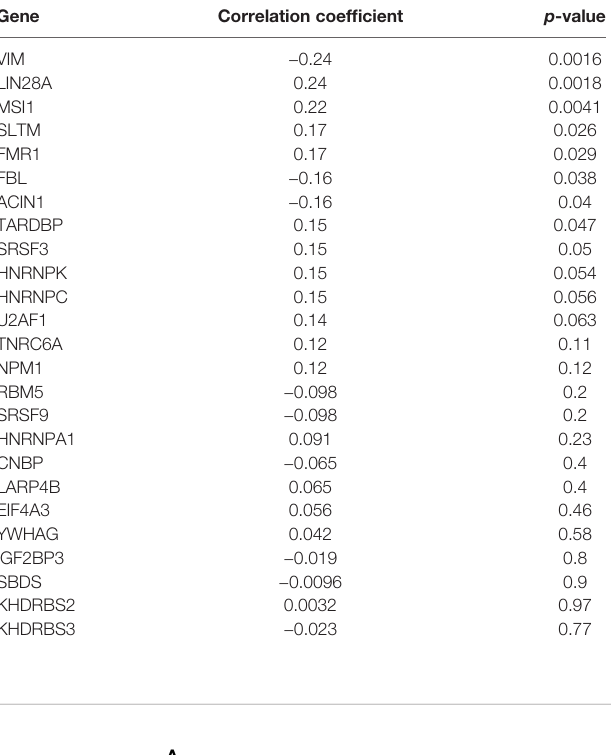
TABLE 2 | The correlation between CENPE and RBPs.